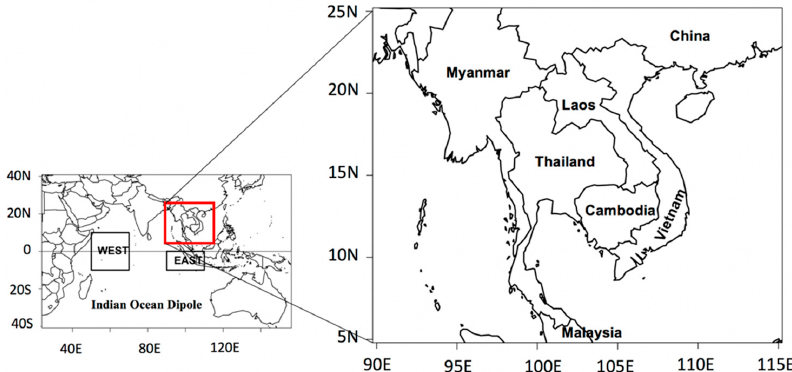
Figure 1. Indochina Peninsula (90° E–115° E, 5° N–25° N). The Indian Ocean Dipole (IOD) mode is defined as the difference in the sea surface temperature between the western (10° S–10° N, 50°–70° E)